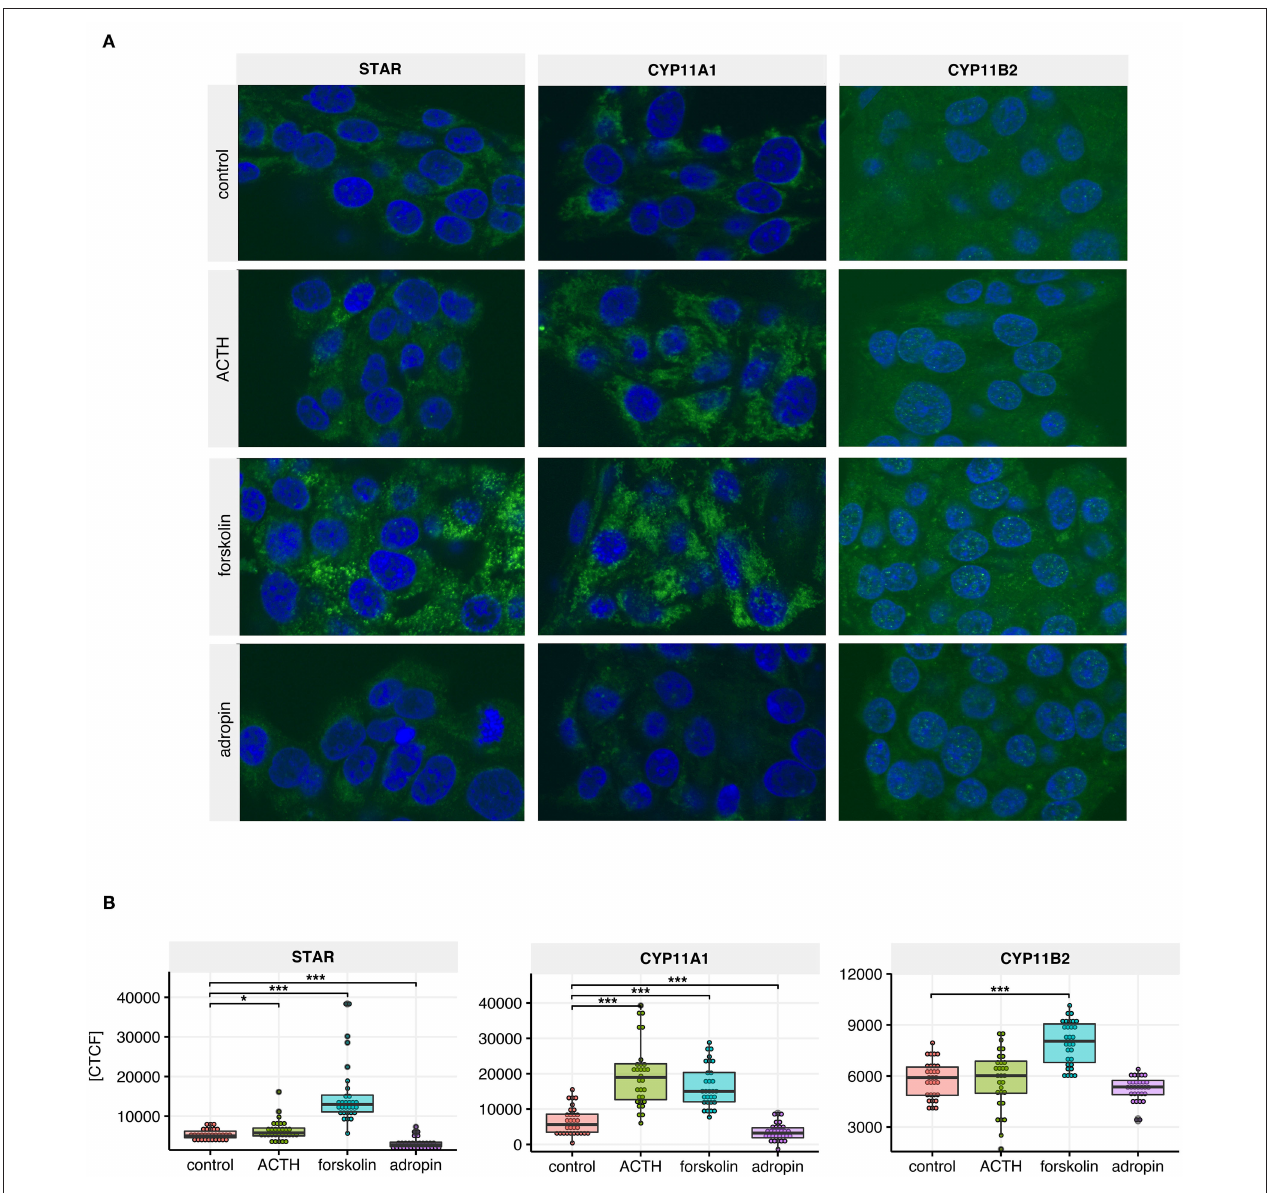
FIGURE 5 | StAR, CYP11A1, CYP11B2 immunoreactivity in untreated HAC15 cells (controls) and cells incubated with ACTH, forskolin and adropin for 24h. (A) Representative images of the HAC15 cells from each group, where the positive reaction of antibody binding was visualized in green, while the cell nuclei were stained in blue with DAPI. (B) Densitometric analysis of the fluorescence intensity ( N = 3 0/group). Statistical differences were determined by the Mann–Whitney U non-parametric test compared to controls. * p < 0.05; *** p < 0.001. CTCF indicates corrected total cell fluorescence.